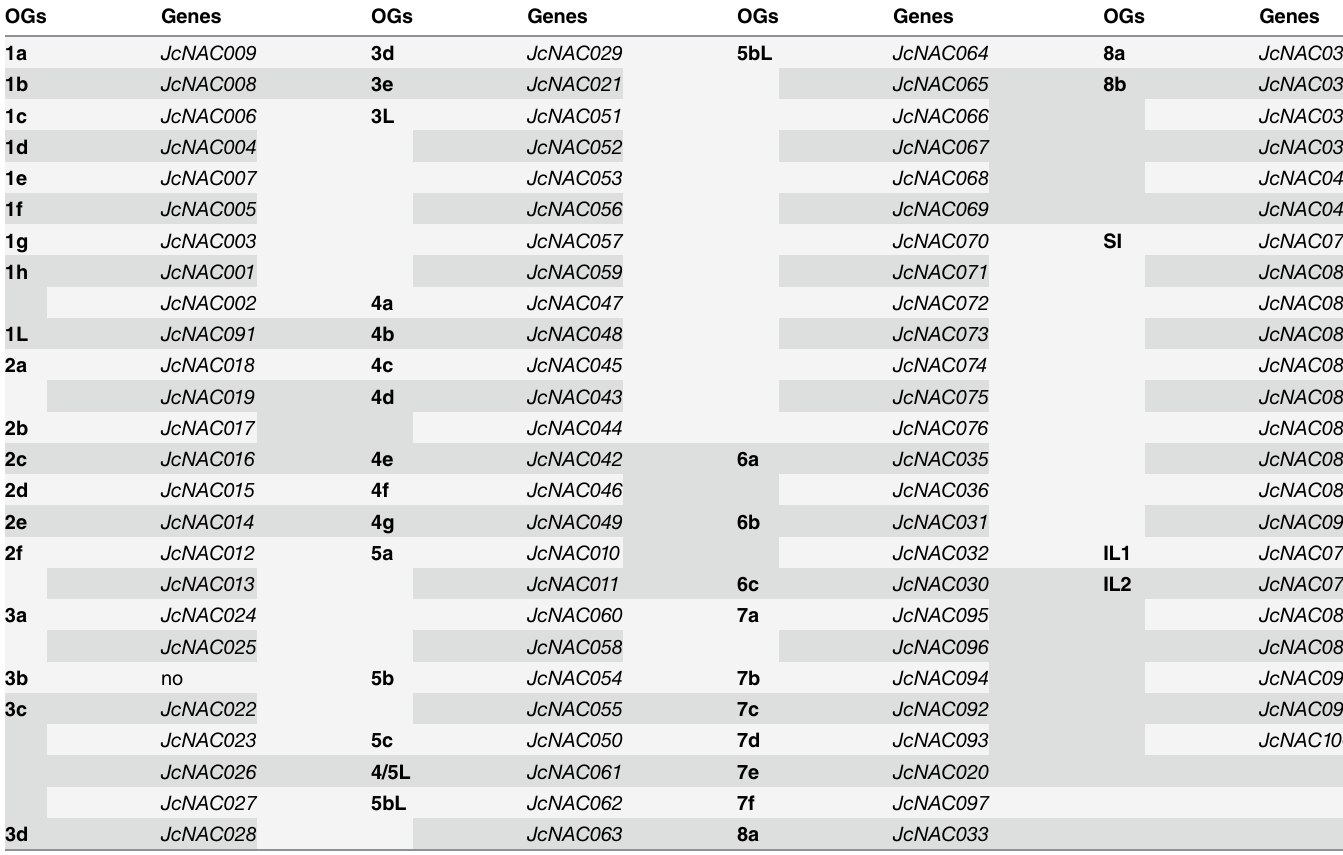
Table 1. Distribution of physic nut NAC genes in orthologous groups